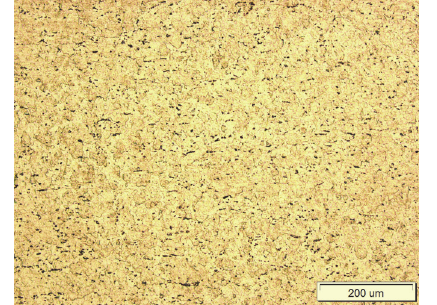
Figure 4: Precipitation of the particles of intermetallic phases in the matrix of the solution- α of the AlZn6Mg0.8Zr alloy